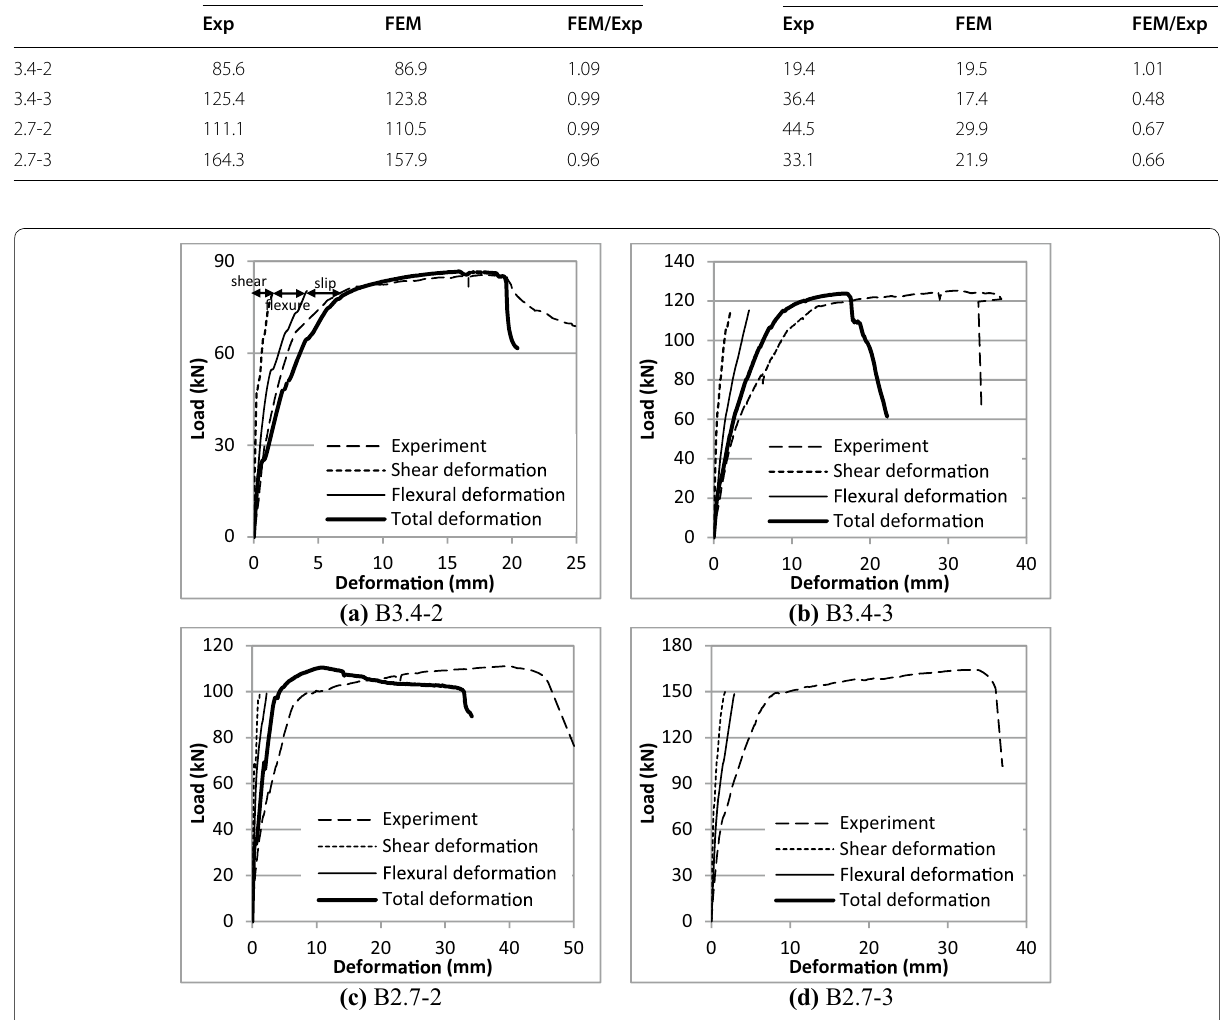
Fig. 7 Results of finite element